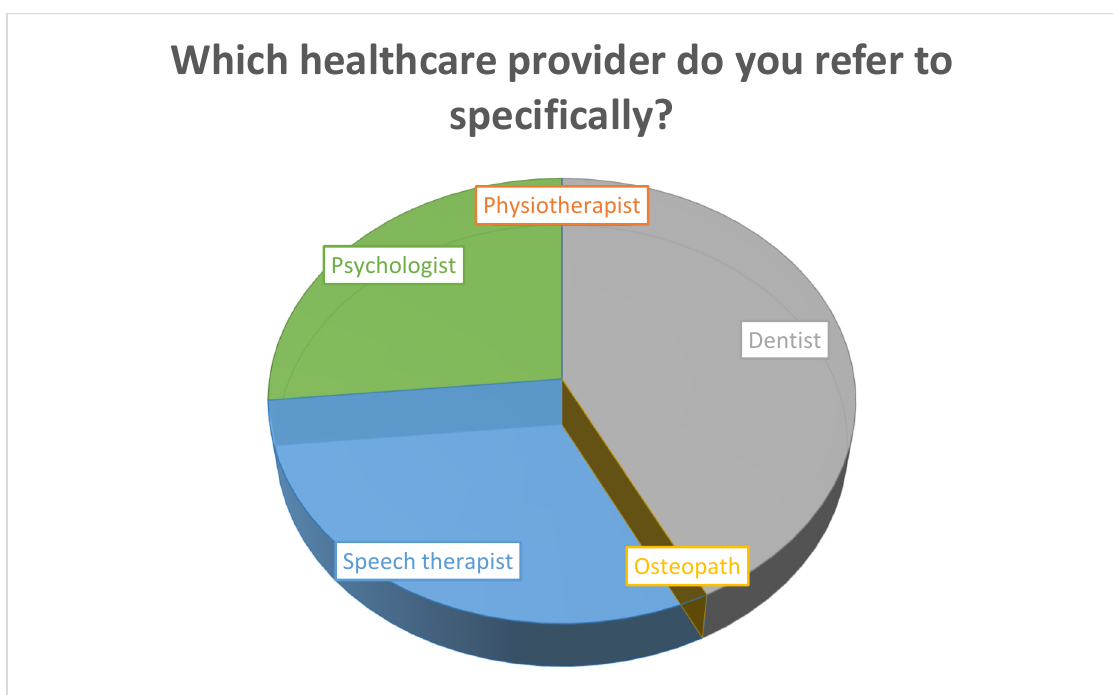
Figure 2. Which healthcare provider/speciality do you refer to specifically?